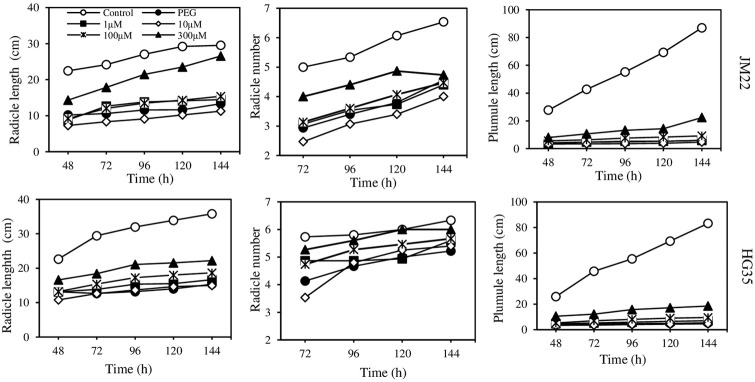
Effects of different concentrations of melatonin on radicle length, radicle number, and plumule length of JM22 and HG35.Values are means of three biological replications.